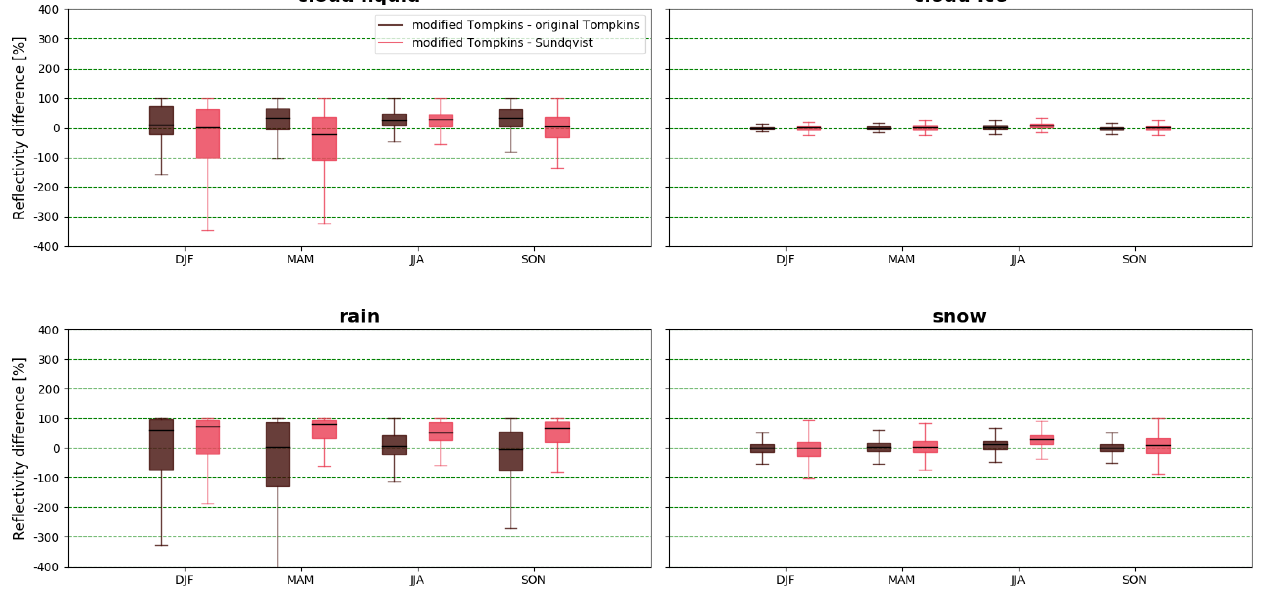
Figure A11. The box plot shows the differences in percent between the modified Tompkins scheme with respect to the two other schemes for different hydrometeors distributed